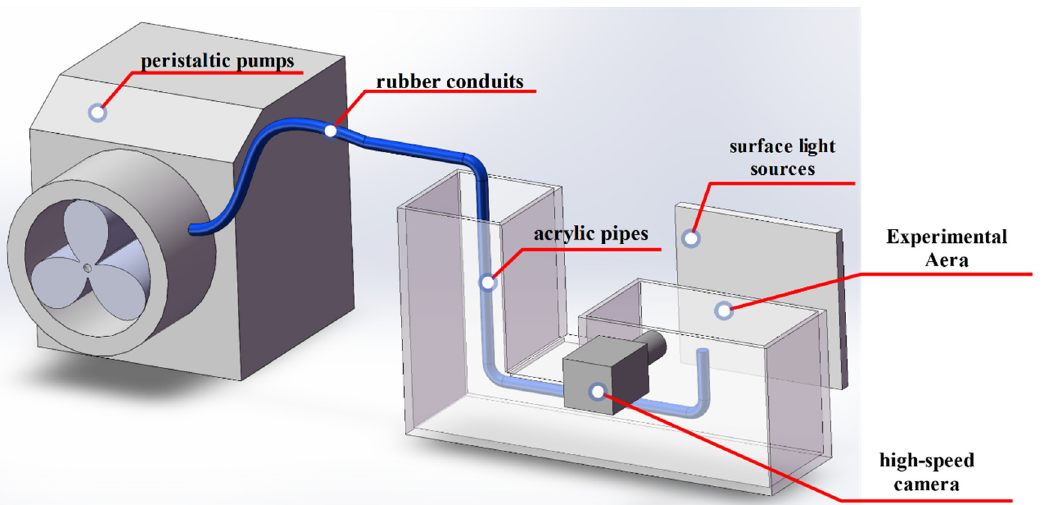
Figure 1. Experimental setup.